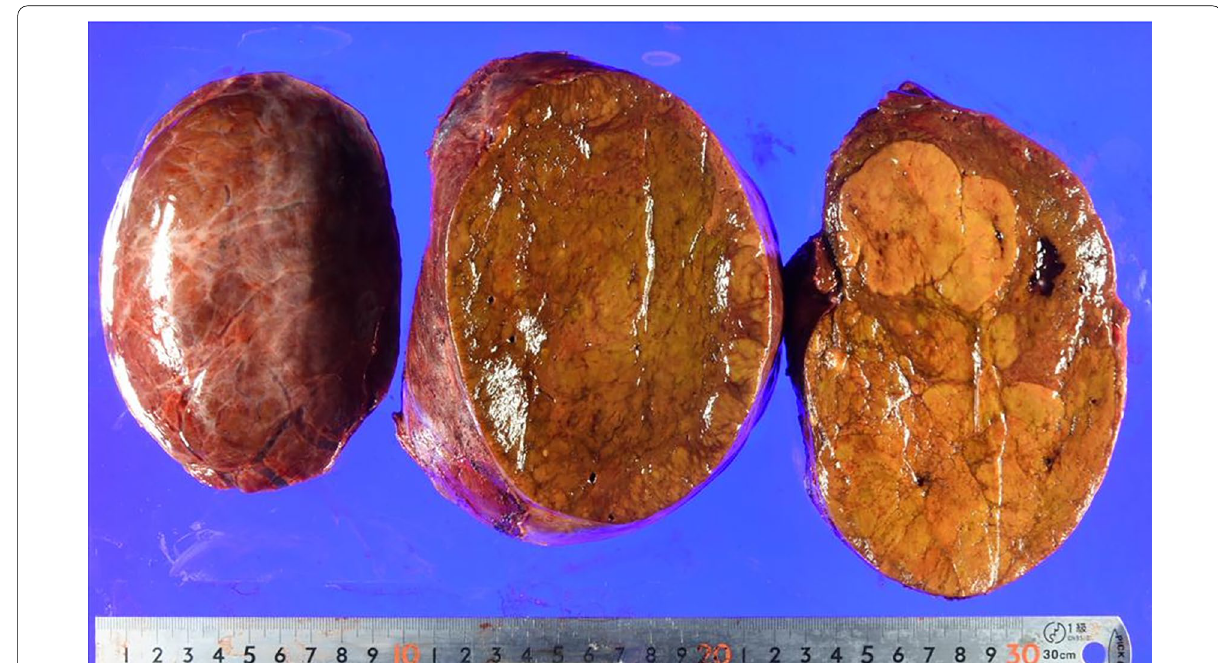
Fig. 3 Photograph of the resected specimen. The tumor measuring 155